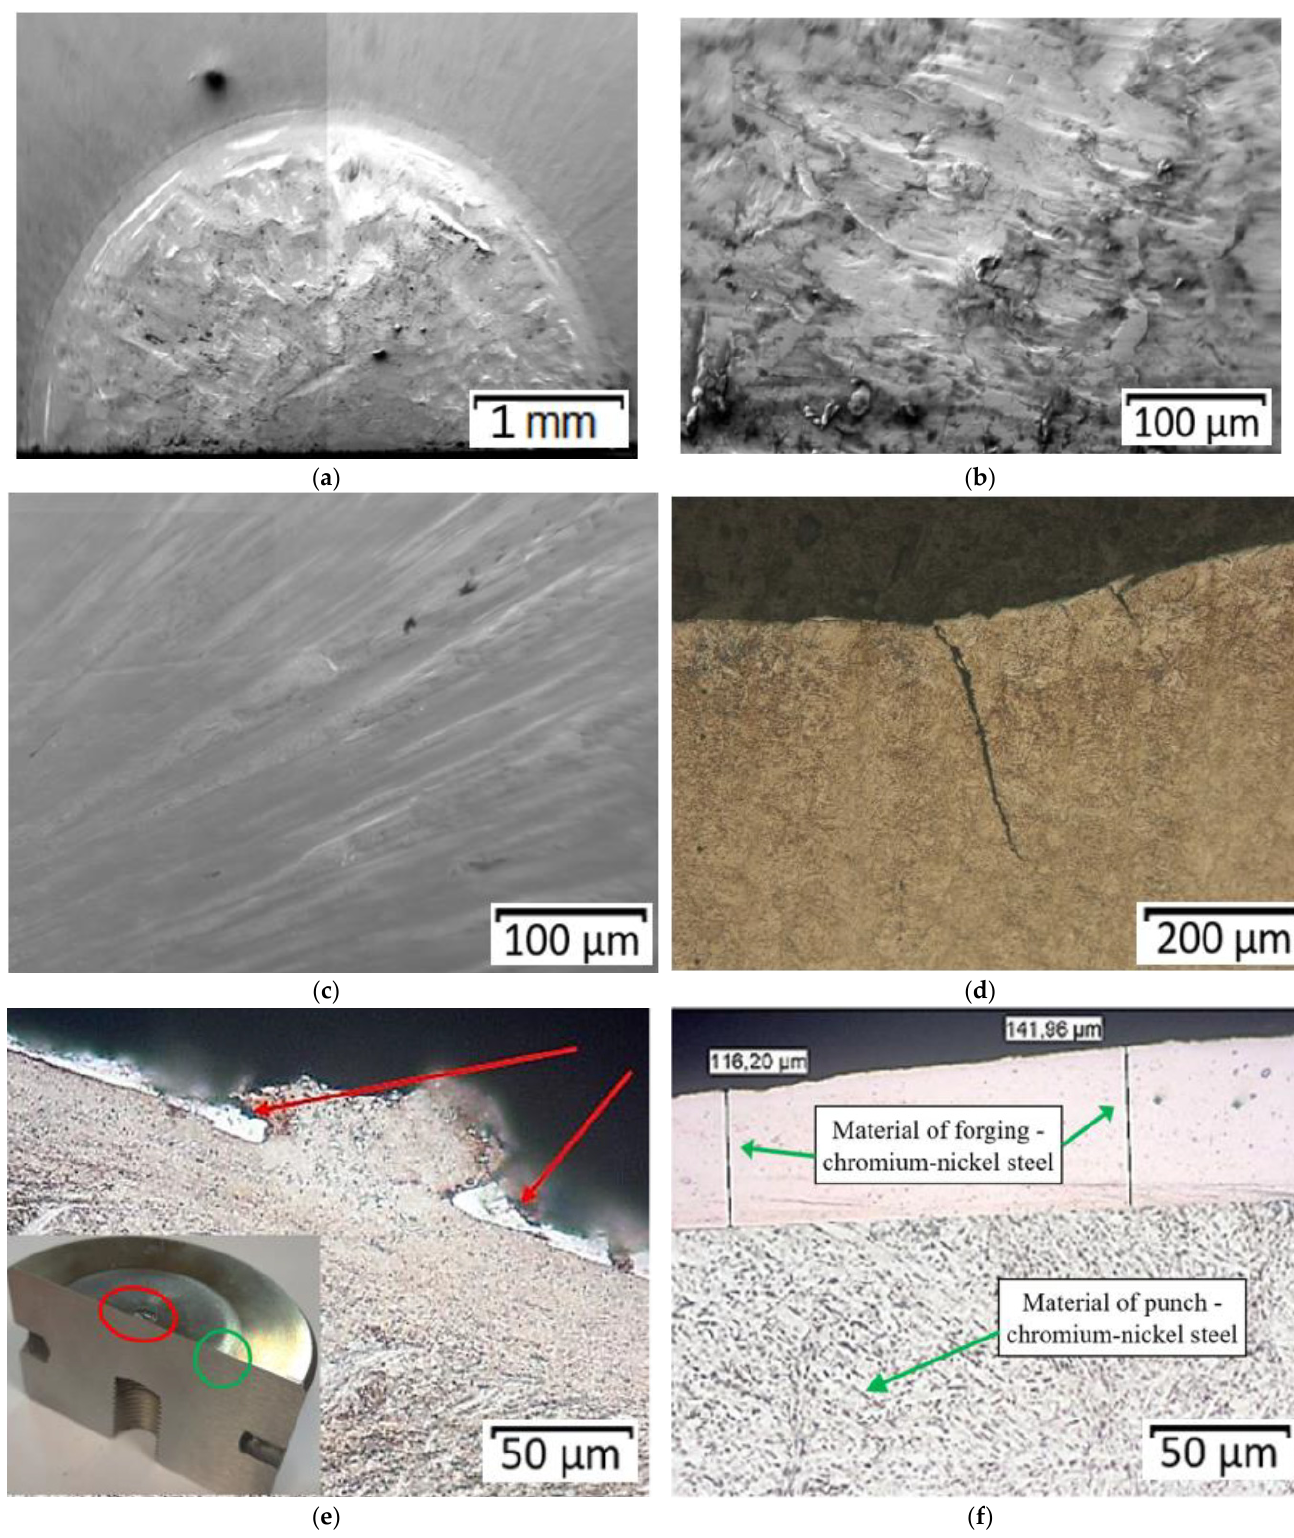
Figure 12. Images of: ( a ) area of the punch’s calotte with visible traces of plastic deformation, ( b ) SEM from the punch calotte area (marked with a red circle in Figure 11e) with a zone of grooves and stickings, ( c ) SEM from the selected area (green)—visible stickings of the forging material ( d ) area of calotte base—mechanical crack, ( e ) calotte—crack of the surface layer, ( f ) area of punch—sticking the forging material to the surface of the tool.